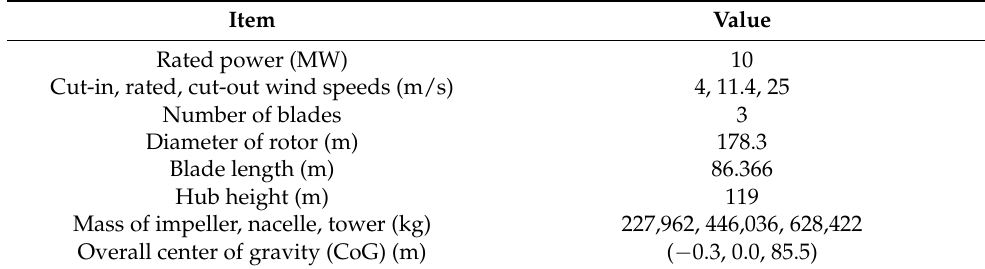
Table 1. Main parameters of the DTU 10MW reference wind turbine [21].